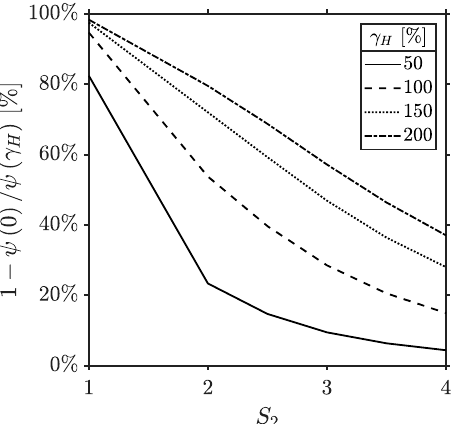
Figure 4. Percentage reductions of the ψ function with the secondary shape factors at different levels of shear strain. Table 1. Percentage reduction of the function with the shear strain for different values of the secondary shape factor. Table 4. Overview of the geometric and mechanical parameters used for the parametric FEAs.